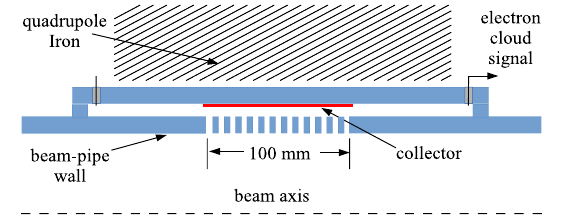
FIG. 2. Schematic cross section of the electron detector, which is located near the longitudinal center of the quadrupole magnet. The holes in the beam-pipe wall allow cloud electrons to reach the collector.